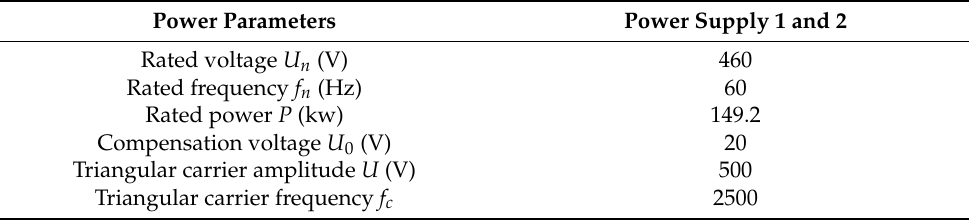
Table 3. Power supply data.